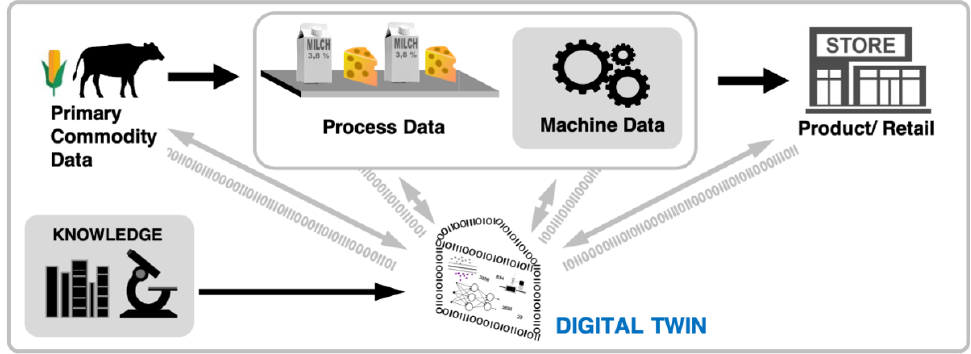
Figure 1. The digital food twin which integrates the data from various